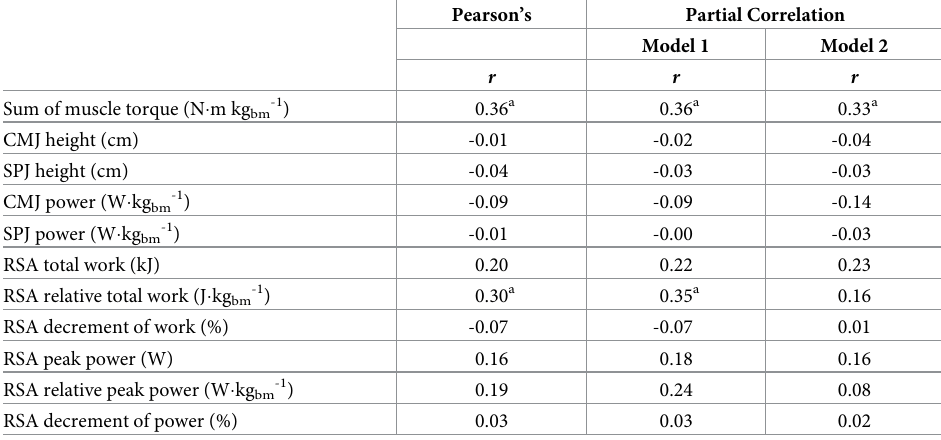
Table 4. Pearson’s and partial correlations between exercise performance and Iron concentration (n = 50).